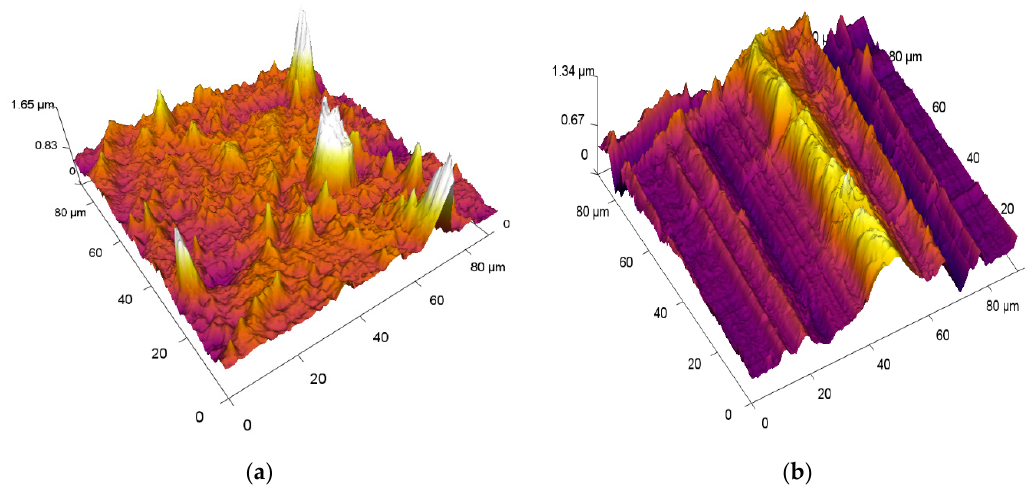
Figure 5. Surface roughness evaluated by the atomic force microscopy (AFM): ( a ) Si3N4–Sa = 0,148 µm; ( b ) 90MnCrV8–Sa = 0.161 µm. ( b ) 90MnCrV8–Sa = 0.161 µ